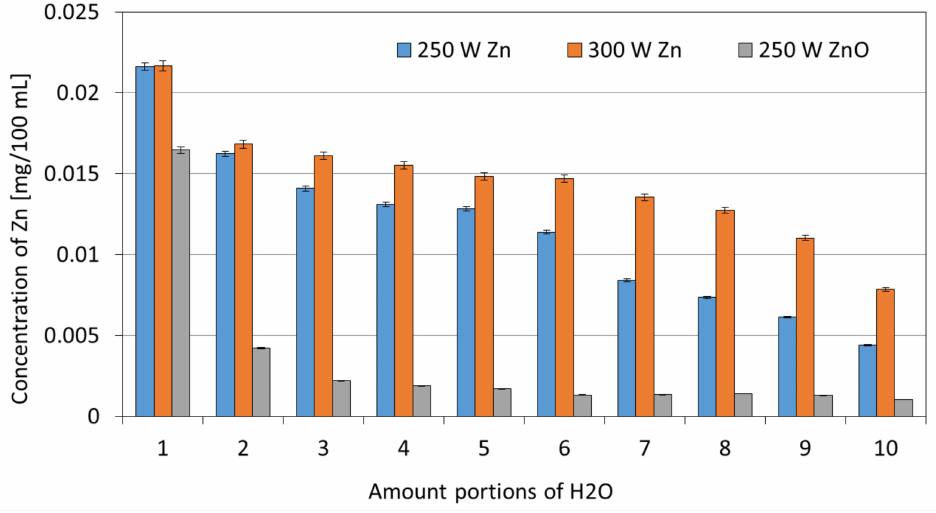
Figure 8. The Zn concentrations in filtrates obtained in the filtration processes of demineralized water through membranes with one-component coatings.